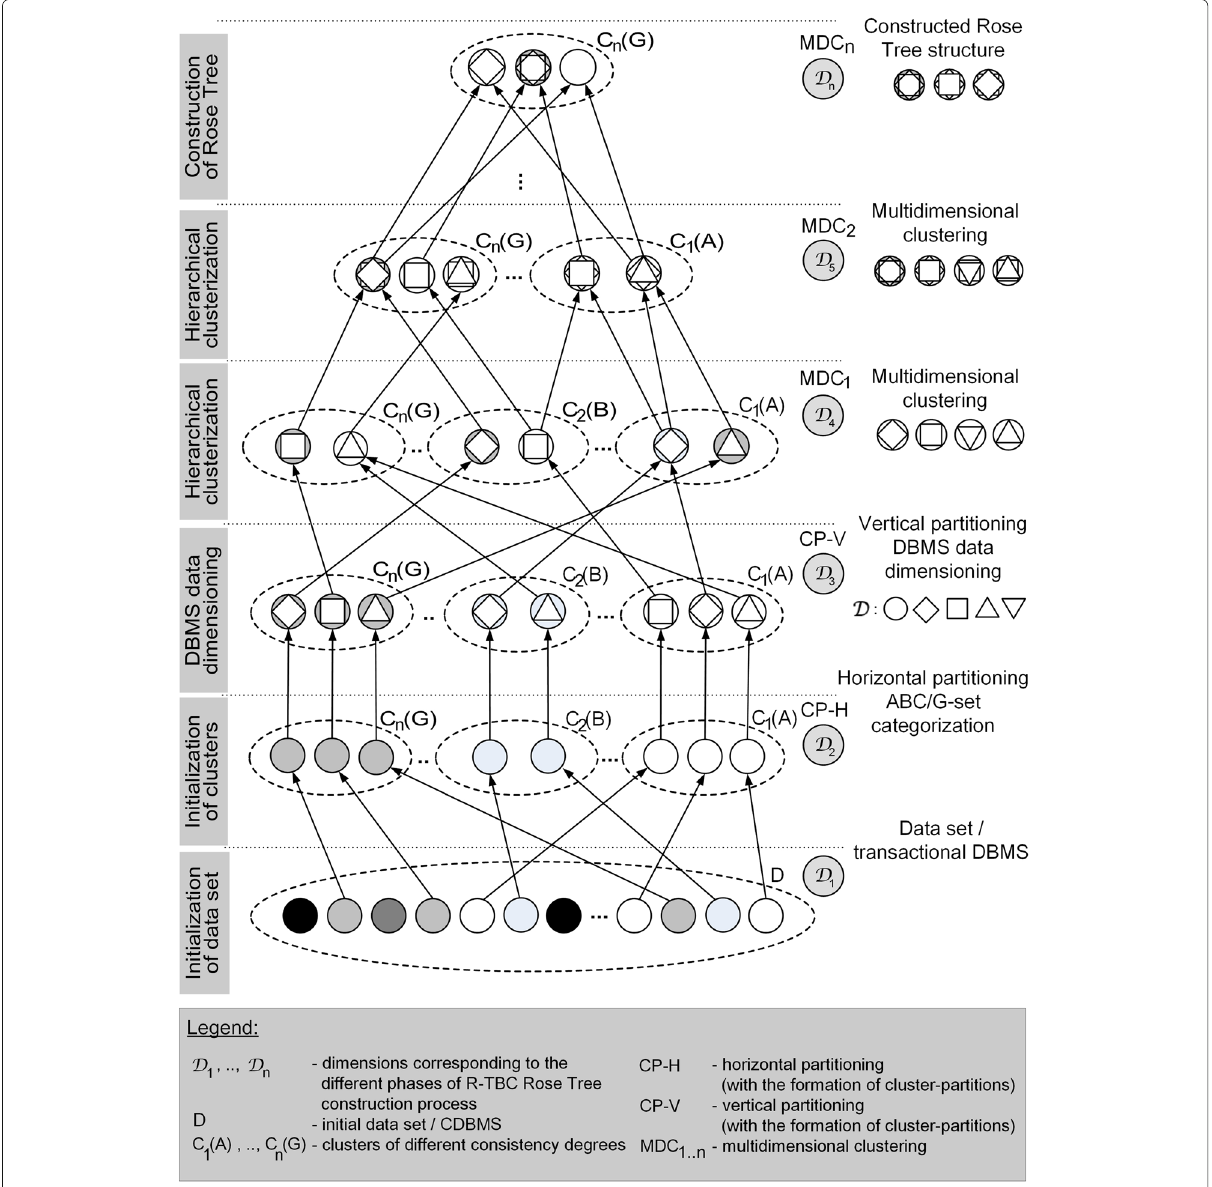
Fig. 8 Process of constructing the R-TBC tree of consistency for transactional database in a hybrid cloud